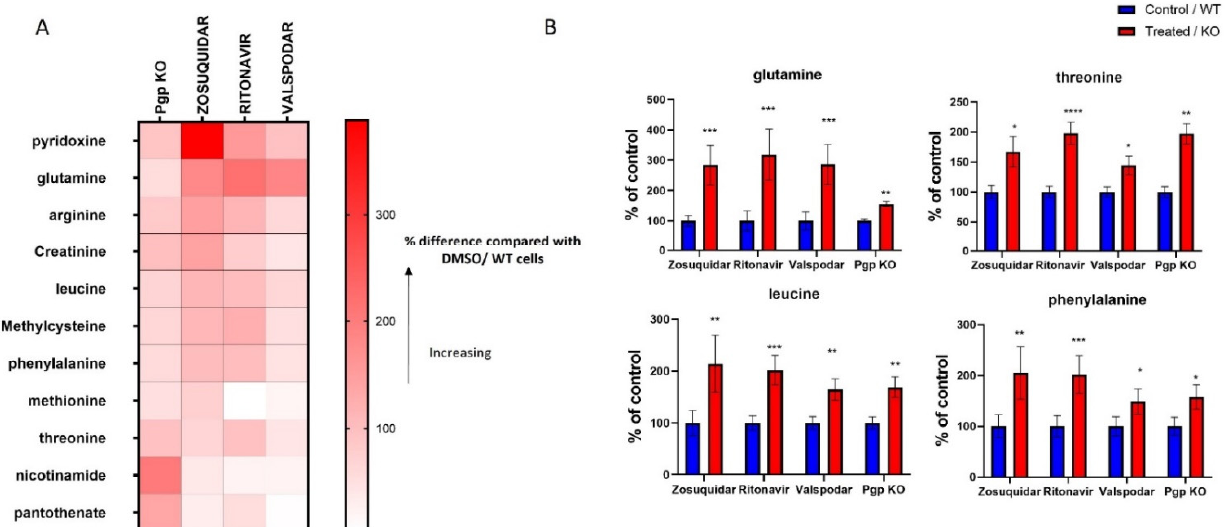
Figure 1. Heat map ( A ) and bar graphs ( B ) representing changes in metabolites induced by Pgp inhibition in cells. The data represent changes in metabolites in response to Pgp KO and Pgp inhibition by zosuquidar (5 µM), ritonavir (10 µM), valspodar (50 nM). The data representing changes in zosuquidar inhibition were acquired from 3 individual experiments, each experiment was performed with a minimum of 6 replicates, and the data are presented as the mean of 3 repeats. The data from other inhibitors and Pgp KO represent the mean of 1 independent experiment, which was performed with at least 6 replicates. ( A ) The data are presented as the percentage change compared with control (DMSO/WT). ( B ) The data were normalized by dividing the mean (peak area) of treated/KO group with the control group and are presented as a percentage (mean ± SEM) of the control group. Significance of these results was determined using Mann–Whitney test, results with * p < 0.05, ** p < 0.01, *** p < 0.001, **** p < 0.0001 were considered